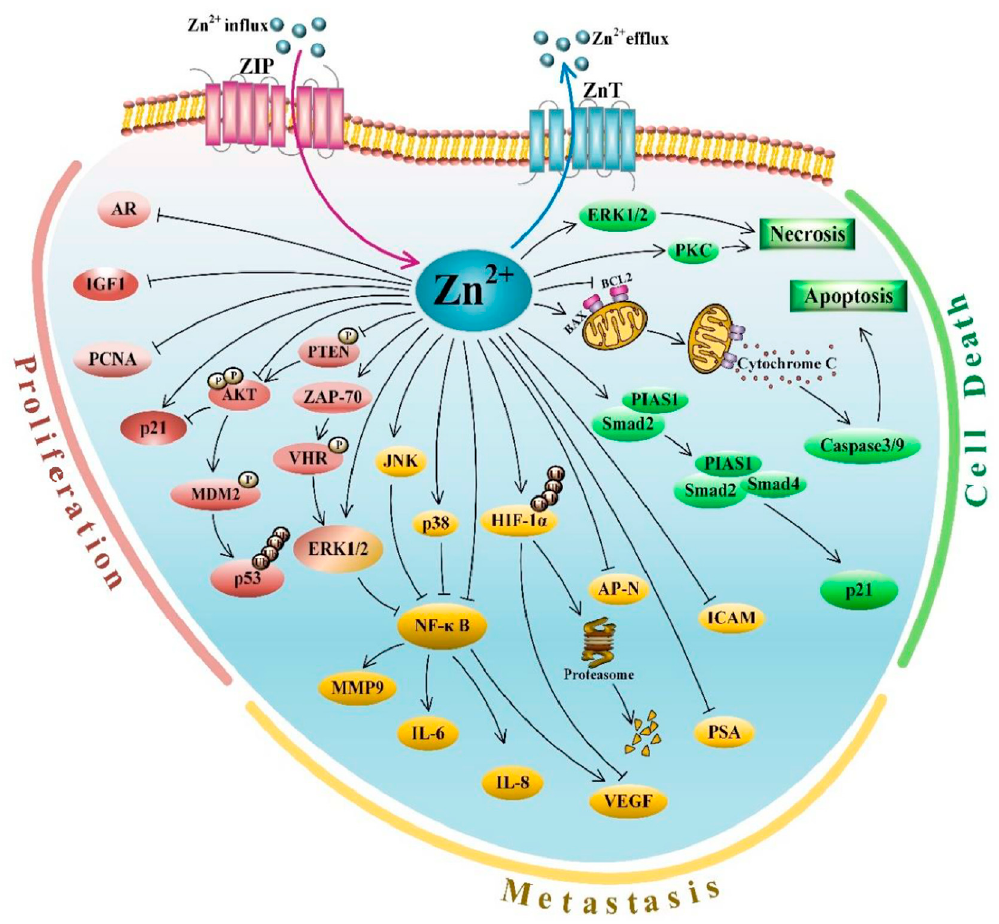
Figure 1. An overview of molecular signaling pathways mediated by Zn in prostate cancer. Zn is involved in various antiproliferative and proapoptotic pathways to exert its antitumor activities, including suppressing cell proliferation, inducing cell death, and inhibiting metastasis. Zn-regulated molecules involved in proliferation, metastasis, and cell death, as well as Zn transporters, are grouped and differentially colored. Black T bar: inhibiting the function of Zn or proteins; Blue arrow: transporting Zn from cytoplasm to extracellular fluid; Purple arrow: transporting Zn from the extracellular fluid into the cytoplasm; Black arrow: activating function of Zn or proteins (Adapted from Li et al., 2020 [54] under the Creative Commons License 4.0 International (CC BY 4.0)).